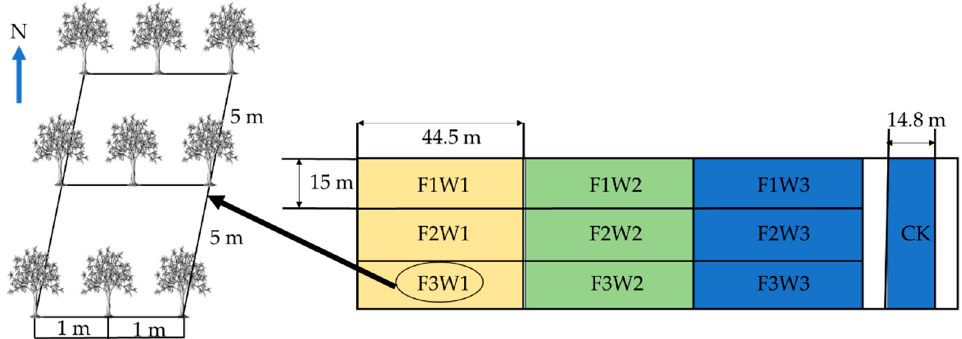
Figure 2. The Korla fragrant pear planting model. surface drip (F1), subsurface drip (F2), and root zone infiltration (F3); 70% ET C (W1), 85% ET C (W2), and 100% ET C (W3); Flood irrigation at 100% ET C served as the check (CK) or